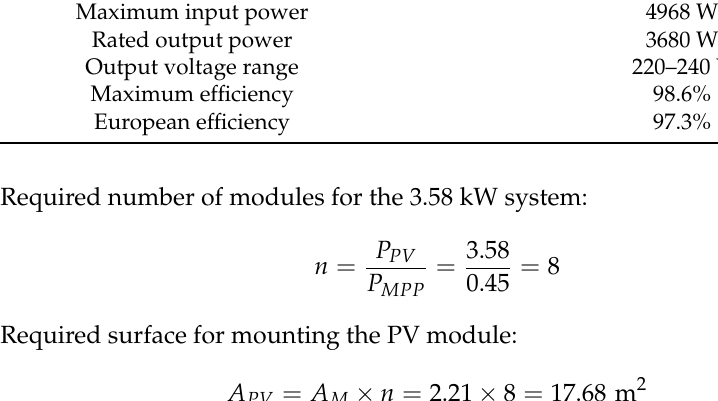
Table 3. Technical characteristics of inverters HUAWEI SUN2000L-3.68KTL [29]. Feature